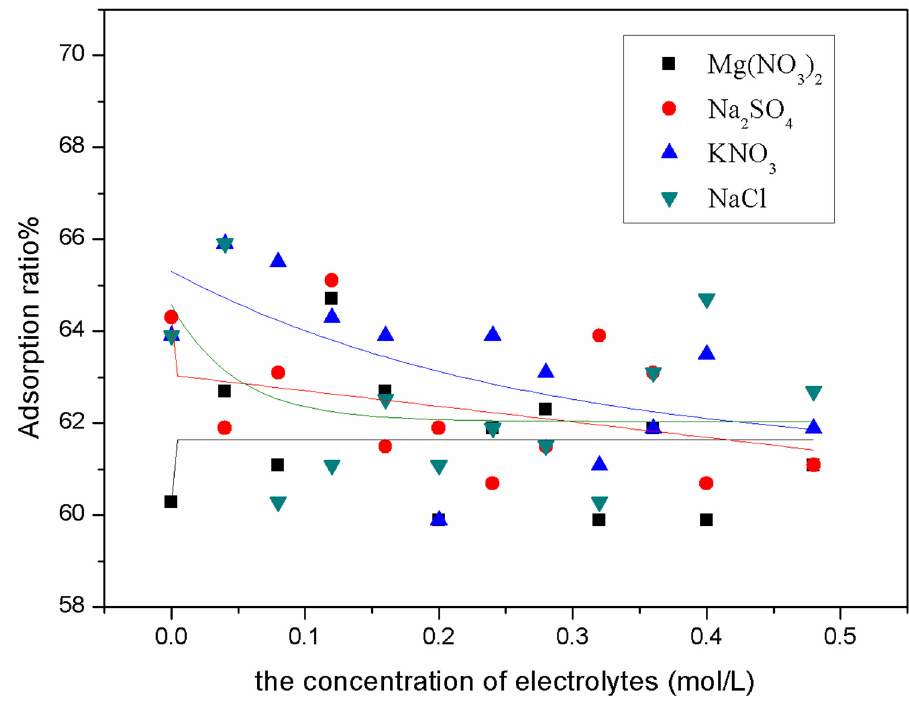
Figure 5. Effect of ionic strength (anion/cation with different valence states). (Experiment conditions: solid/liquid ratio = 0.038 g/L; C electrolyte = 0~0.48 mol/L; C 0 [Th(IV)] = 19.00 ± 0.10 mg/L; pH = 3.00 ± 0.05; T = 298.15 ± 1.00 K; t = 0.5 h.)